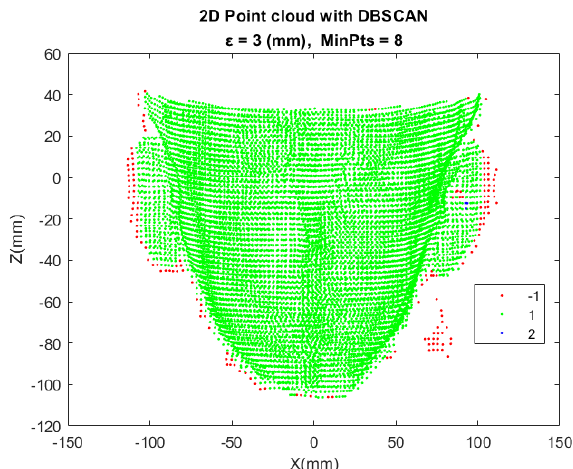
Figure 16. The 2D point cloud after DBSCAN processing.